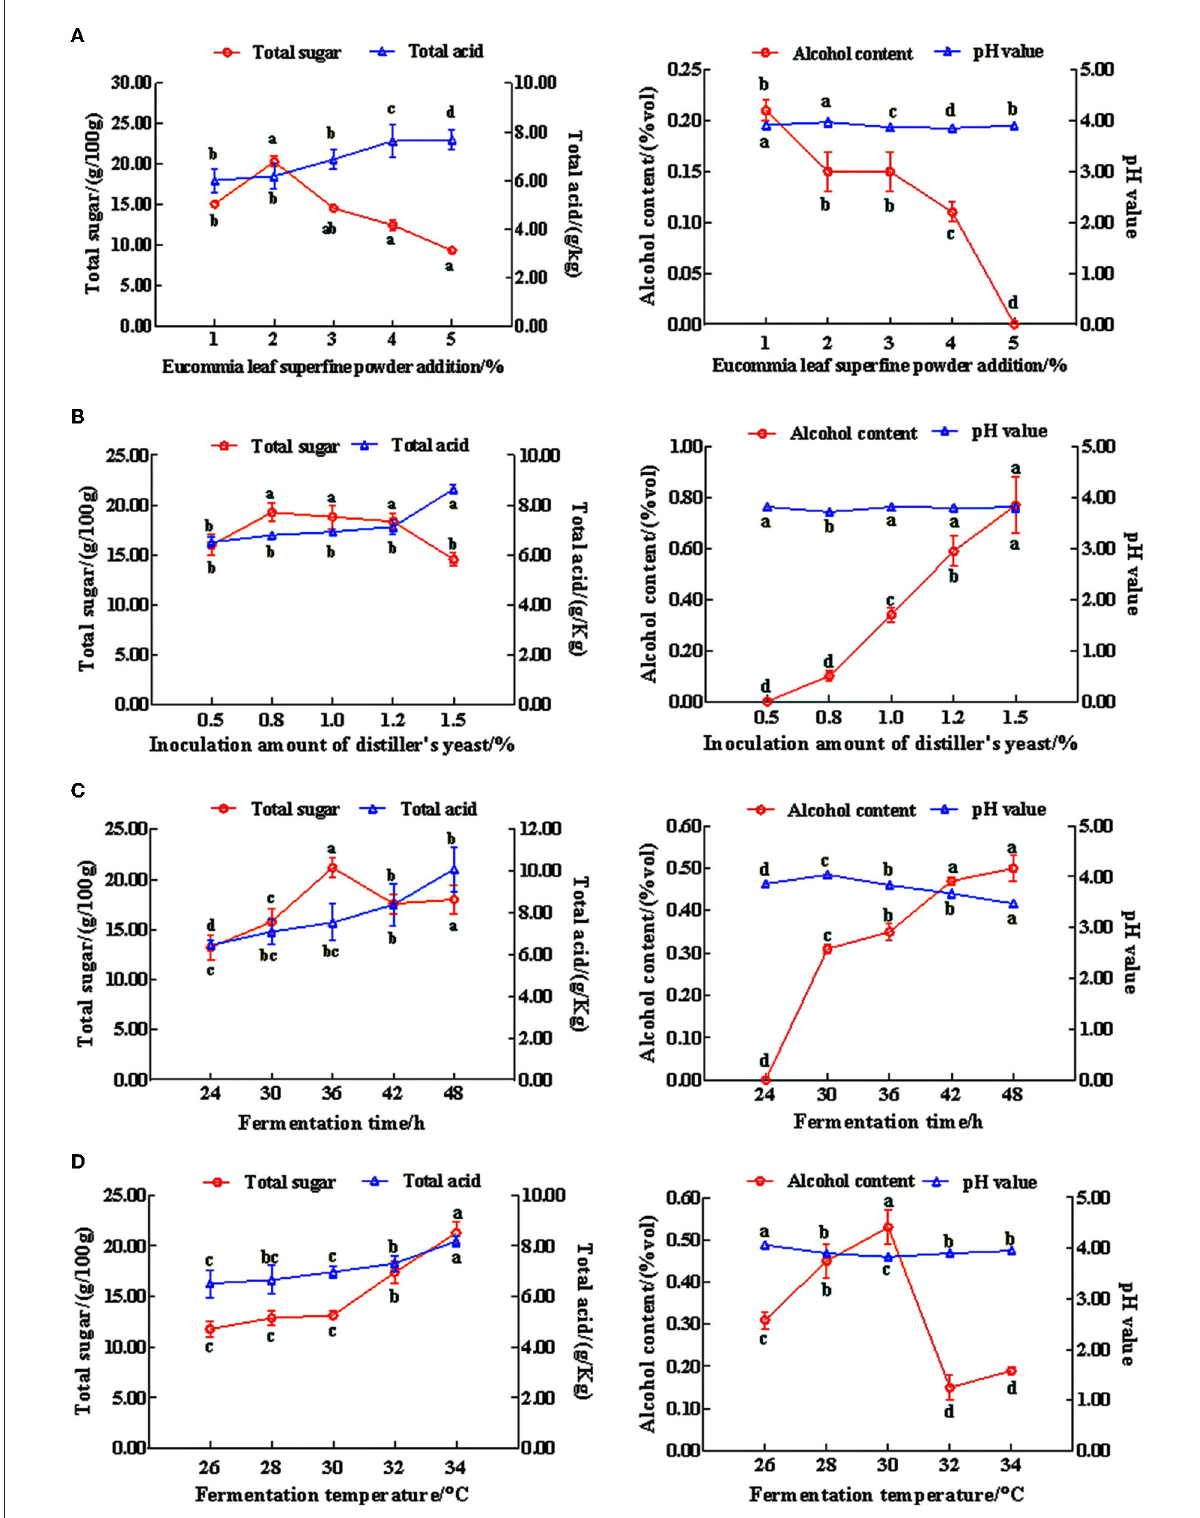
FIGURE1 The effects on the total sugar and total acid, alcohol content, and pH value of mixed sweet rice wine. (A) Amount of Eucommia leaf superfine powder; (B) inoculation amount of distiller’s yeast; (C) fermentation time; (D) fermentation temperature ( n = 3). Different lowercase letters indicate significant differences ( p <